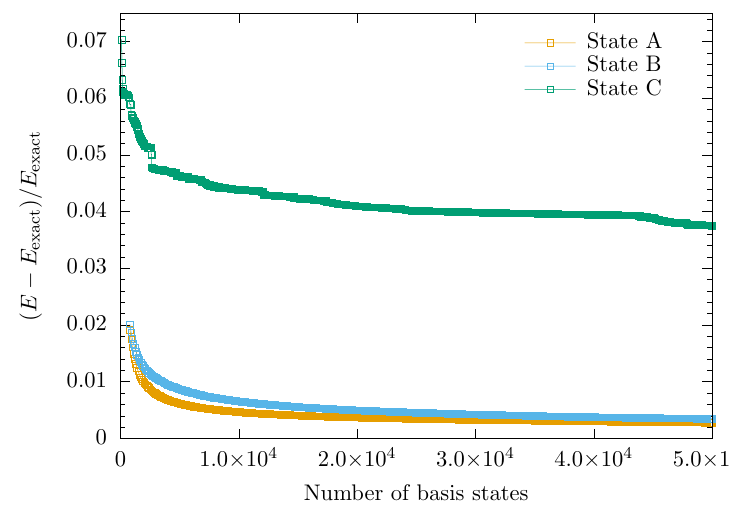
Figure 21: The convergence of the states A, B, and C, for the N = 10 particle = 20 → c = 10 obtained using the matrix element renormalization group quench c i f (MERG). For state A, and B, MERG is performed with N whereas for state C, MERG is performed with N